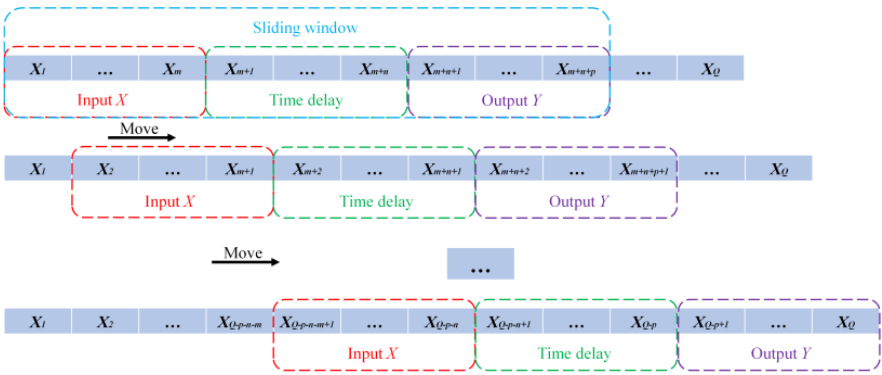
Figure 2. Flowchart of the sliding window.